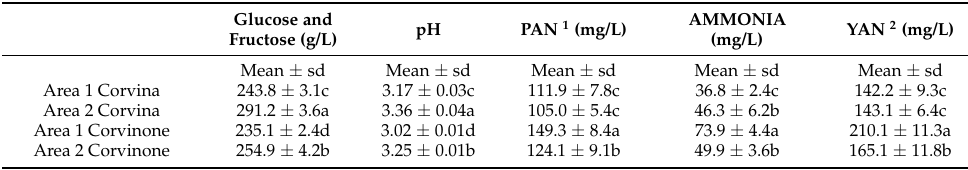
Table 1. Enological parameters of musts at